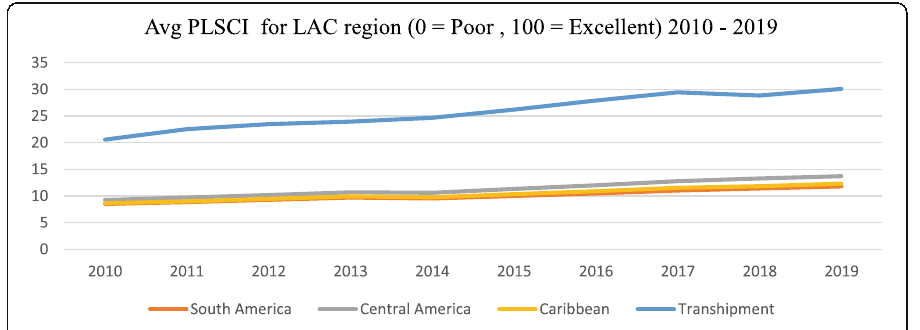
Fig. 6 Port Liner Shipping Connectivity Index (PLCI). Index (Maximum Q1 2006 = 100).